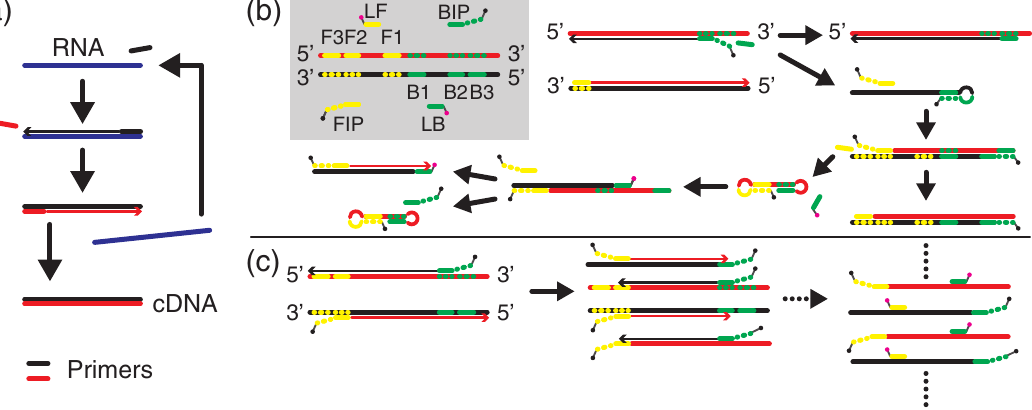
Figure 1. Nucleic acid transcription and amplifications. ( a ) Schematic of a cycle of reverse tran- scription from the original RNA (blue) to double-strand (ds) complementary DNA (cDNA) (red). Elongations thanks to polymerase reactions are indicated with arrows. ( b ) LAMP primers of F3, Forward inner primer (FIP), loop forward (LF) primer, B3, backward inner primer (BIP), and loop backward (LB) primer are summarized on gray domain. Dotted-line regions are complementary to F1, F2, F3, B1, B2, and B3, respectively. The FIP and BIP have biotin label (black dot) at the 5’ end with an extra sequence of TTT, and the LF and LB have fluorescence (FL) label (magenta dot) together with an extra sequence TTT. Only the initial several steps in LAMP are illustrated. ( c ) One-step PCR associated with FL-probe hybridization. Biotin-conjugated primers, that is, FIP and BIP in ( b ) contribute to amplification of the target cDNA (left to center). After the amplification, FL-labeled probes, that is, LF and LB in ( b ), are hybridized to the PCR amplicons